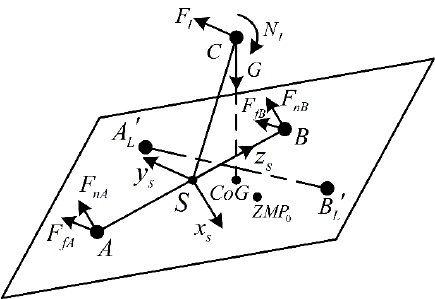
Figure 4. Projection of the next set of support feet and contact force at the current support feet.